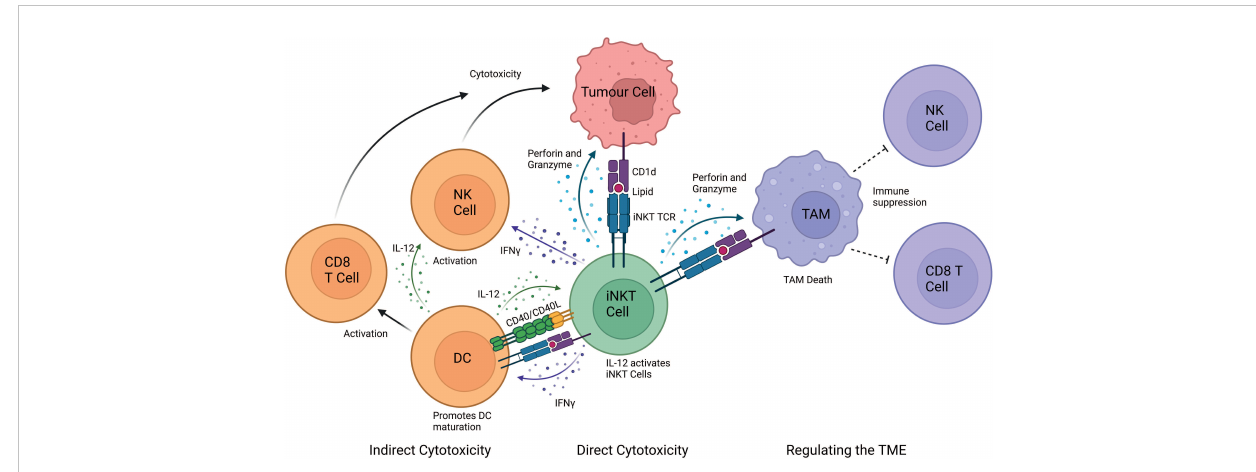
FIGURE 1 iNKT cell mediated mechanisms of tumour cytotoxicity. iNKT can exert their cytotoxic function either directly, indirectly and by regulating the tumour microenvironment (TME). In the direct mechanism, iNKT cells can recognise the tumour through the engagement of their iNKT cell TCR with a CD1d-lipid complex expressed on the surface of the tumour cell. iNKT cells can indirectly exert cytotoxic functions by interacting with other immune cells in the TME. IFN- g released by iNKT cells can activate NK cells to perform their anti-tumour cell effector functions. Additionally, IFN- g release activates the maturation of DCs and stimulates CD8 + T cells. iNKT cells and DCs reciprocally activate each other in a CD40-CD40L and CD1d-lipid/TCR antigen-dependent manner, which further stimulates iNKT cells. iNKT cells also regulate the TME by engaging with CD1d-lipid complexes expressed on tumour-associated macrophages (TAMs). This interaction promotes iNKT killing of immunosuppressive TAMs, consequently providing a less immunosuppressive environment where tumour-in fi ltrating NK cells and CD8 + cytotoxic T cells can better perform their functions. Image created in